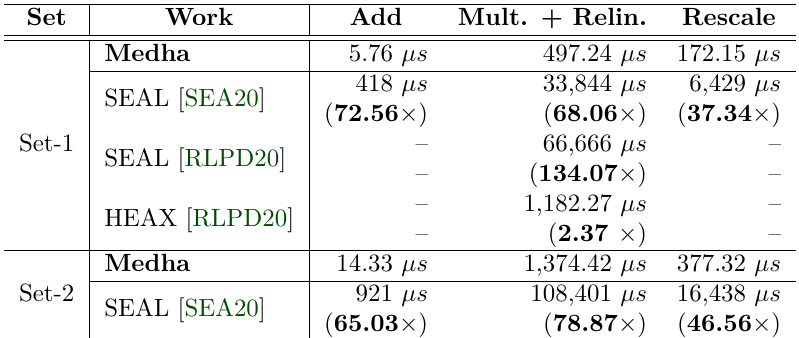
Table 4: Latency Comparison with the SEAL [SEA20] and HEAX [RLPD20]